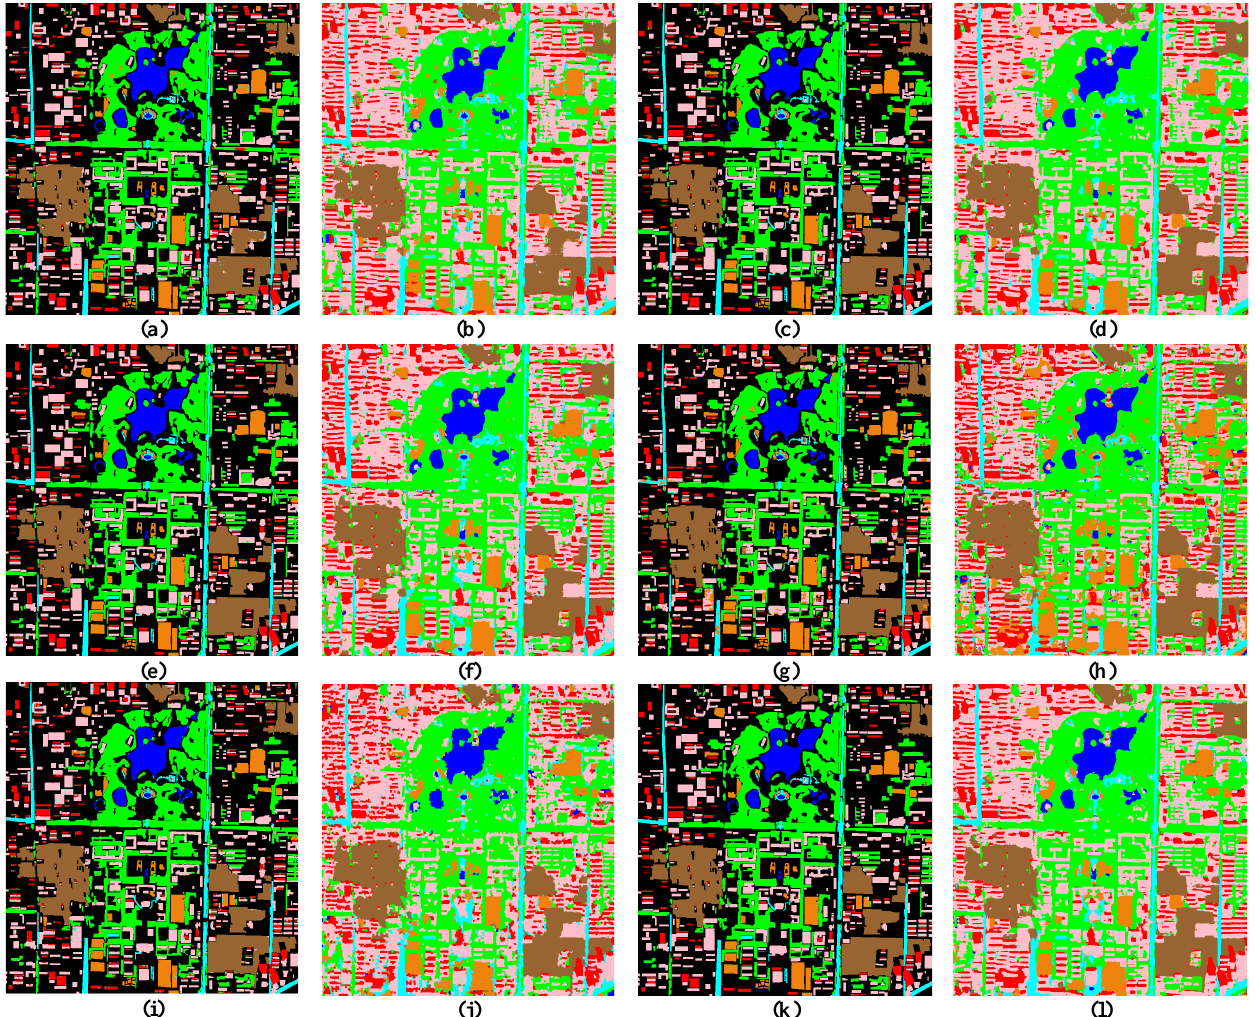
Figure 11. Classification maps of different methods on the Xi’an Urban area Images(800 × 830), each method has two classification maps: one is image with ground truth, while the other is overall image. ( a , b ) Pixel-Centric+SE-Net(Res18). ( c , d ) ANSS+SE-Net(Res18). ( e , f ) ACO-SS+DBAF-Net. ( g , h ) DMIL. ( i , j ) SML-CNN ( k , l )